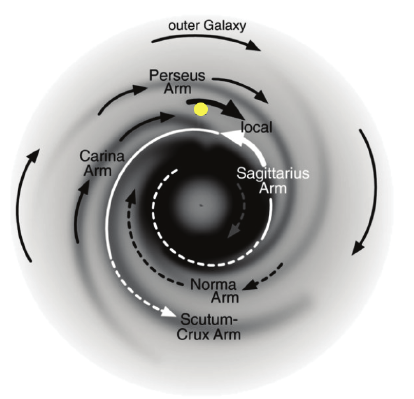
(cid:3) B Figure 8. Sketch of the large-scale configuration of reg in the (cid:3) B Galactic disk from the model of [33]. reg runs clockwise (black arrows) in most of the disk and counterclockwise (white arrows) in a restricted region of reversed field. The dashed arrows are more uncertain than the solid arrows. The yellow dot indicates the position of the Sun.